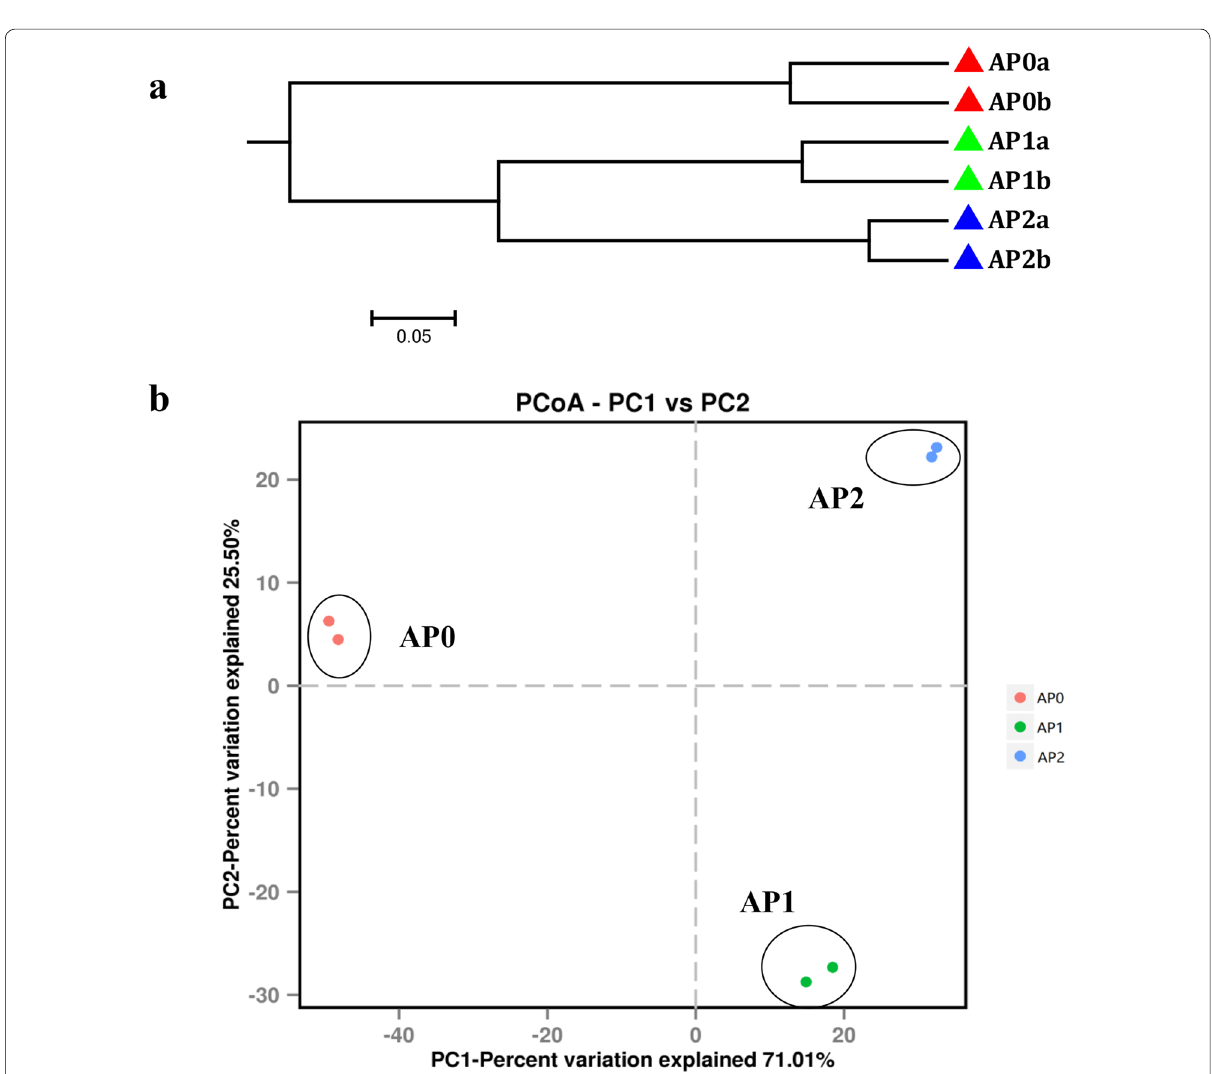
Fig. 3 Unweighted pair-group method with arithmetic mean (UPGMA) dendrogram ( a ) and principal coordinate analysis (PCoA) ( b ) of fungal communities based on Bray–Curtis distance. AP0, AP1 and AP2 represent soils with continuously cropping histories of Andrographis paniculata for